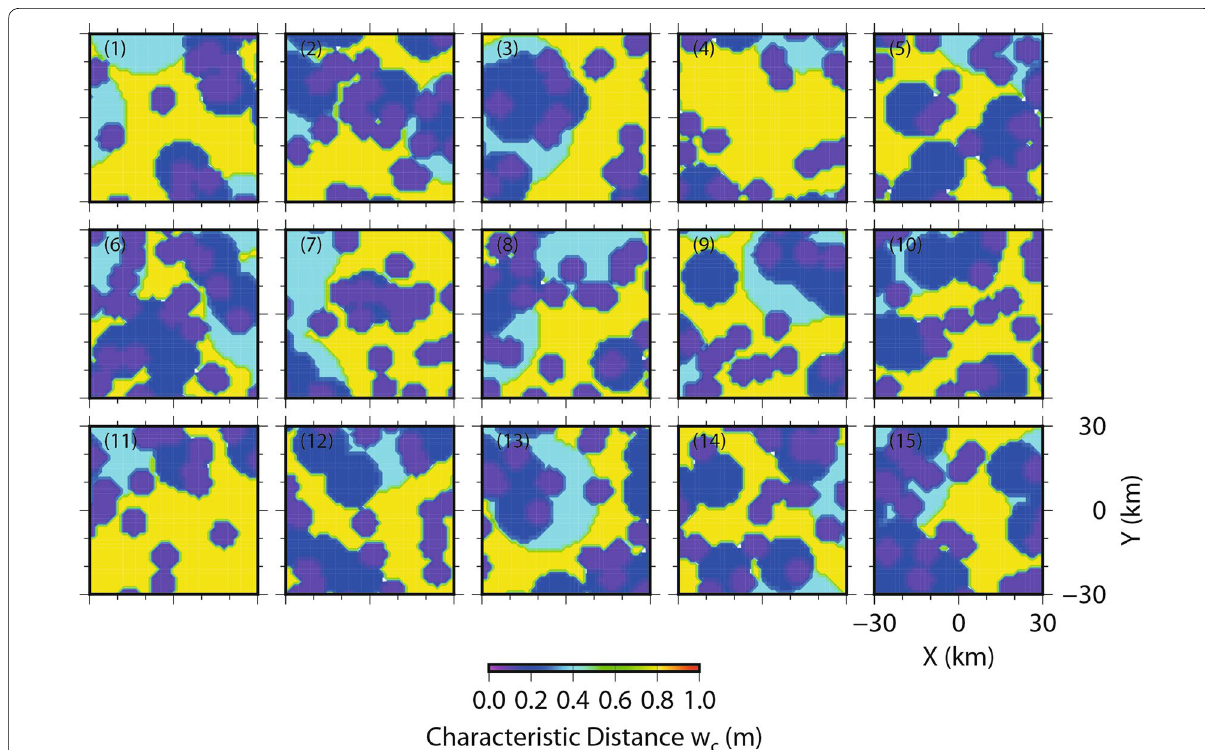
Fig. 6 Spatial distribution of randomly generated multiscale patches for 15 cases, randomly generated under the same fractal size–number distribution. Each model includes three different ranks of patches ( k = 2,3, and 4 ), denoted by light blue , dark blue , and purple , respectively. The background region is yellow , with w c = 0.8m and w 0 = 2.4m , and is assumed to represent a larger patch of rank k =